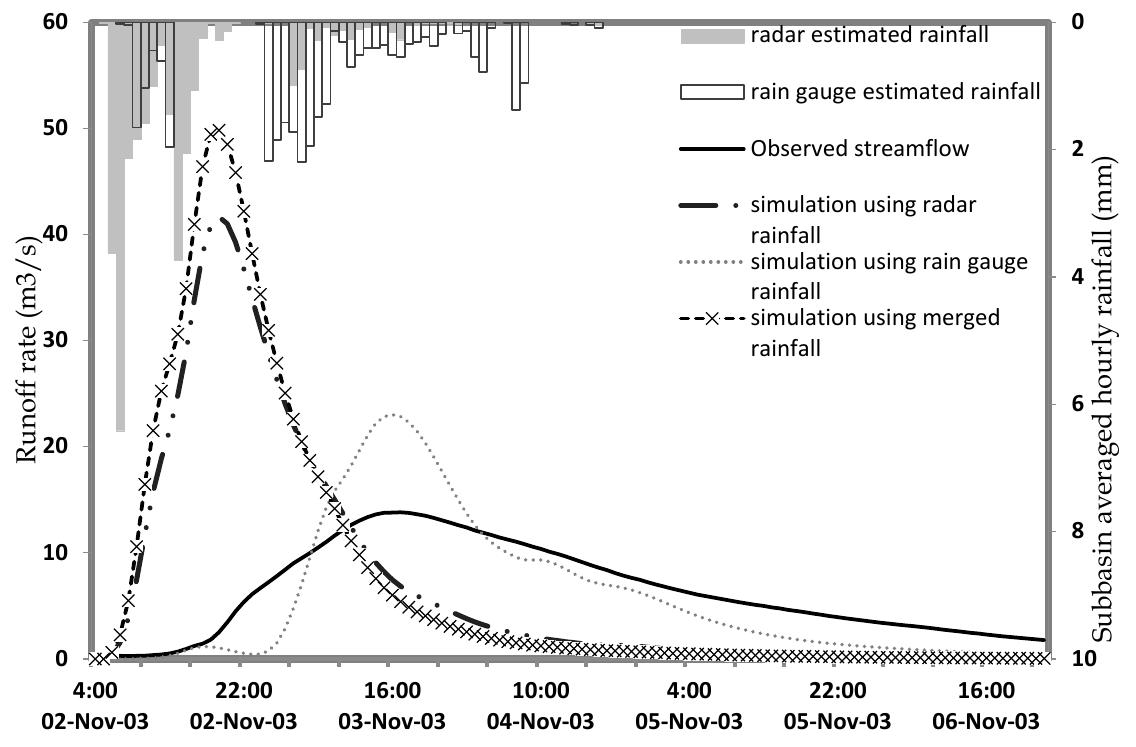
Figure 25. Comparison of estimated and observed hydrographs using different rainfall estimates for the 2 November 2003 event with Green and Ampt modeling option.